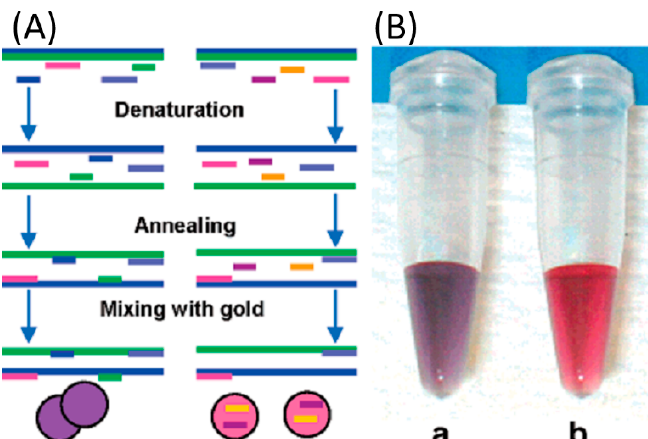
Figure 6. ( A ) Schematic of the detection protocol. The mixture of PCR product and probes is denatured and annealed below the melting temperature of the complementary probes followed by addition of gold colloid. The long blue and green lines represent the PCR-amplified DNA fragments, and the pink and light blue medium bars represent the excess PCR primers. The short blue and green bars are complementary probes that bind, resulting in Au-np aggregation (purple color). The short purple and orange bars are non-complementary probes that do not bind and adsorb to the Au-np, preventing Au-np aggregation and leaving the solution pink. ( B ) Color photographs of the resulting solutions with complementary probes ( a ) and non-complementary probes ( b ). Reprinted with permission from Journal of the American Chemical Society, 2004, 126, 10958–10961. Copyright (2004) American Chemical Society.